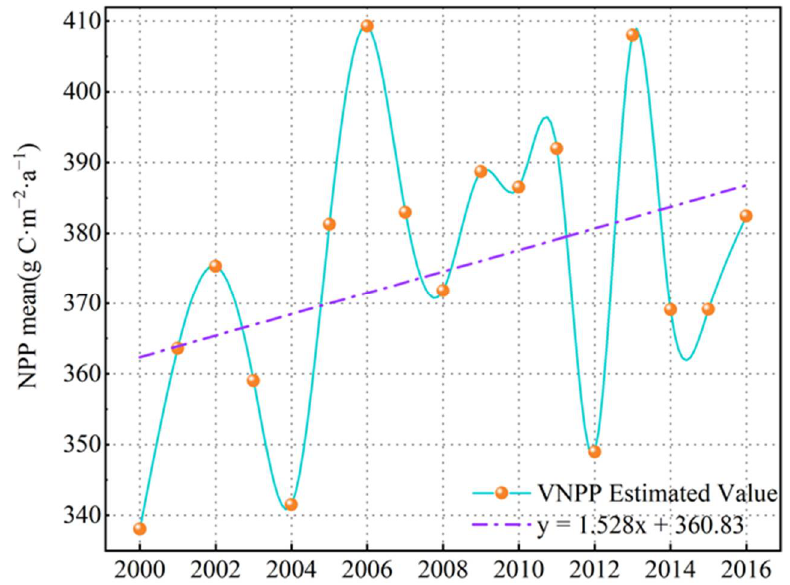
Figure 7. Annual average NPP time series variation.